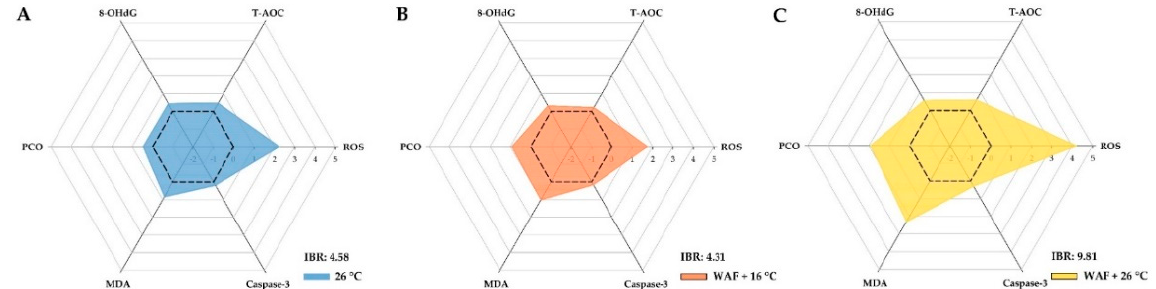
Figure 7. Integrated biomarker response (IBR) indexes for sea cucumber following exposure to elevated temperature (26 ◦ C, light-blue filled, ( A ), water-accommodated fractions (WAF) of Oman crude oil at an optimal temperature of 16 ◦ C (WAF + 16 ◦ C, light-red filled, ( B ), and Oman crude oil WAF at an elevated temperature of 26 ◦ C (WAF + 26 ◦ C, light-yellow filled, ( C ). Biomarker results are denoted relative to the Control (sea cucumber exposed to pre-filtered natural seawater only at an optimal temperature of 16 ◦ C) (black dash lines). The area above 0 denotes the induction of the biomarker, and the area below 0 denotes the reduction of the biomarkers. ROS: Reactive oxygen species; T-AOC: Total antioxidant capacity; 8-OHdG: 8-hydroxy-2 (cid:48) -deoxyguanosine; PCO: Protein carbonyls; MDA: Malondialdehyde.